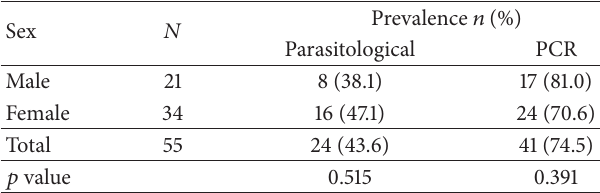
Table 2: Prevalence of camel piroplasmosis in different sexes.